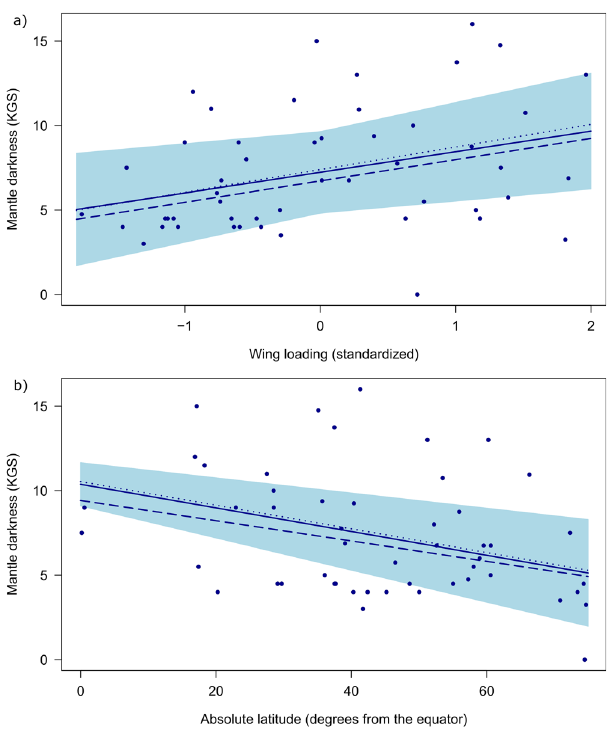
Fig. 2 Model estimates of the effect of wing loading and latitude on mantle darkness, measured on the Kodak Grey Scale (KGS). a Wing loading at 45 degrees from the equator; b absolute latitude (distance from the equator of species ’ breeding and resident ranges in degrees) at sample mean wing loading (0 SD). Predictions for Ornstein-Uhlenbeck (best- supported; solid line with standard error), non-phylogenetic (dotted line) and Brownian motion (dashed line) models of evolution are shown. N = 50 species.